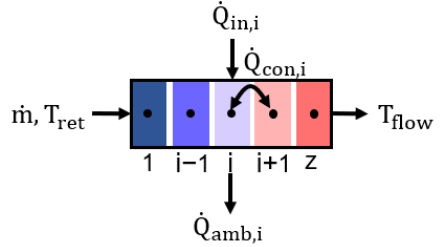
Figure 9. Schematic heat balance of the 1-D capacity model.